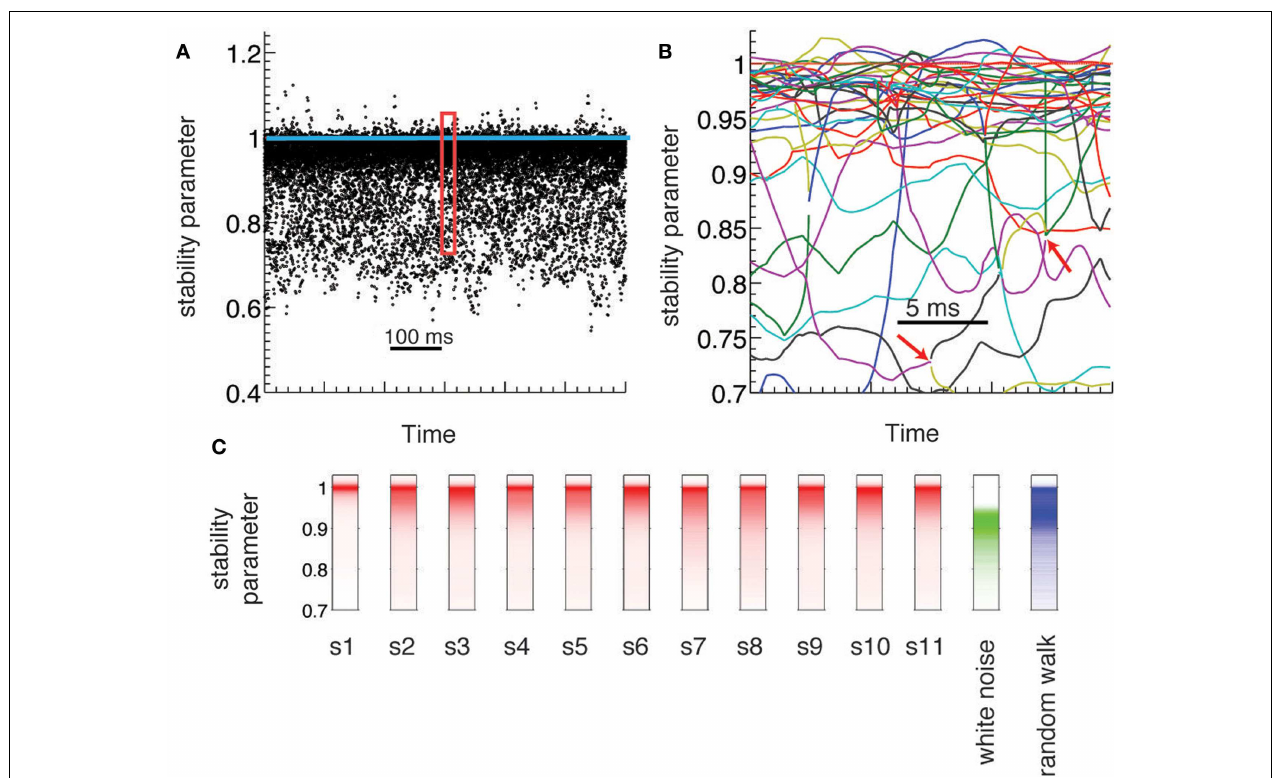
window. Each colored line corresponds to the evolution of a different mode. Red arrows indicate bifurcation points: a complex mode gives rise to two real new born modes (and vice versa). (C ) Histogram of the stability parameter for all subjects (red), and for two synthetic data (white noise and random